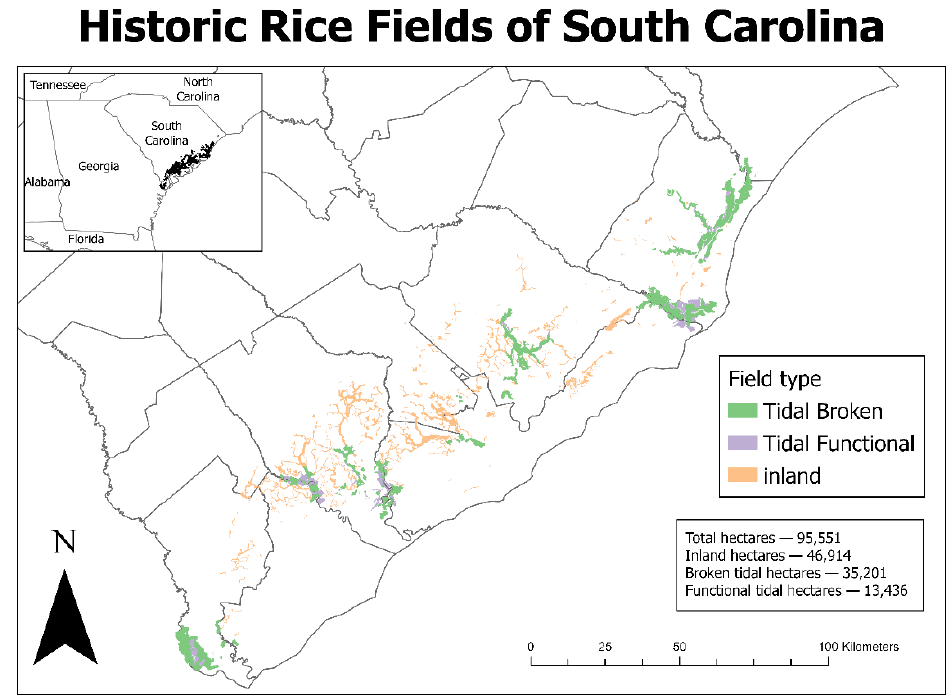
Figure 4. Map of the South Carolina “Rice Kingdom” showing the location and geographic extent of historic rice fields in South Carolina. Green polygons represent broken tidal fields and purple polygons represent functional tidal fields, whereas orange polygons represent inland fields.